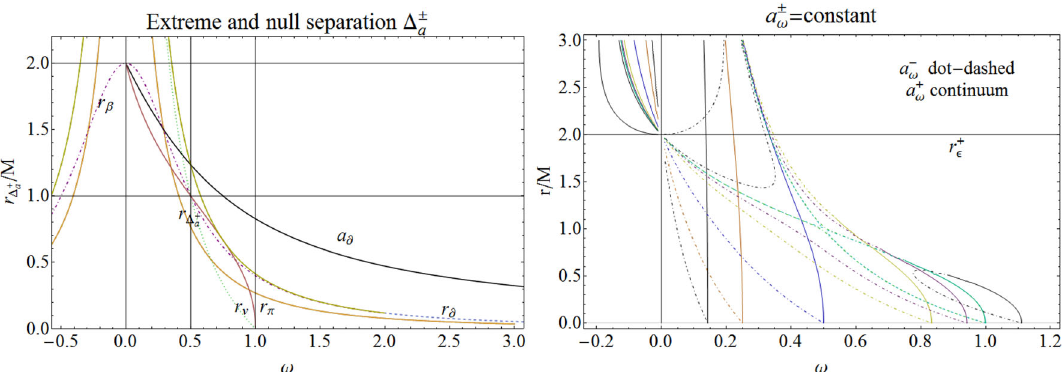
Fig. 11 Left panel: radii { r (cid:2) , r β , r ∂ , r ν , r π } an the spin a ∂ , according to the Eqs. (B5), (16) and (B1), as functions of the frequency ω . Left panel: Spins a ± ω = constant given in Eq. (15) in the plane r / M − ω . Coa- lescence of the Killing horizons r + and r − in the extreme black hole